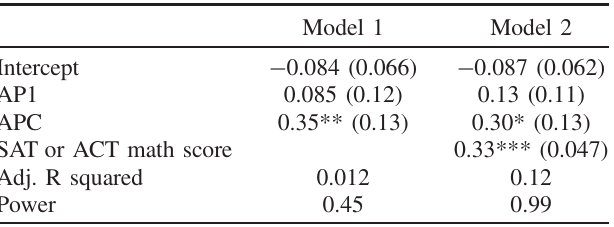
TABLE IV. Regression model of physics 1 course grades on students ’ prior physics experience and students ’ SAT or ACT